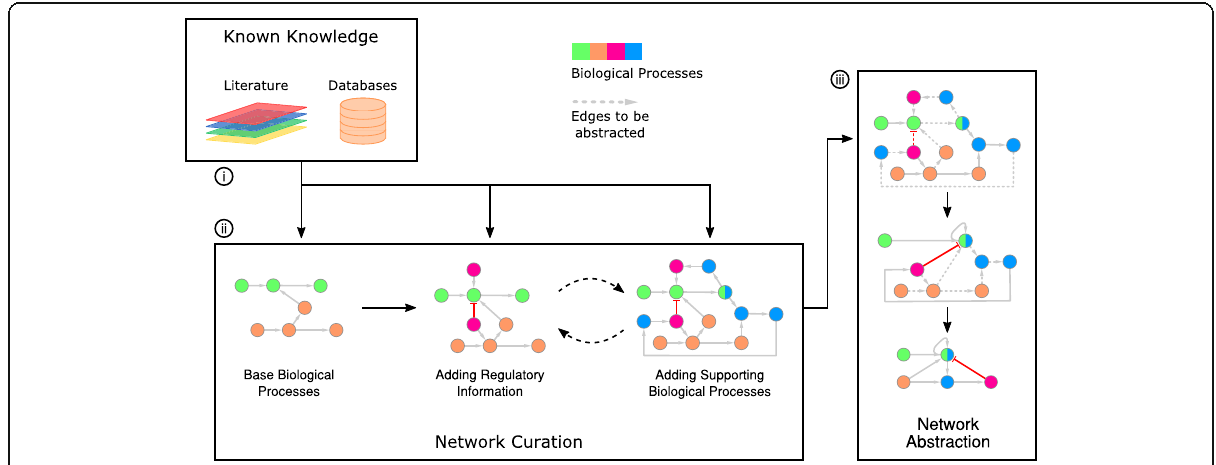
Fig. 1 Methodology overview showing the workflow to construct the abstracted network. (i) Known knowledge in the form of published literature and databases is queried regarding cellular metabolism. (ii) Base biological processes are isolated and then expanded by adding regulators and other related processes as long as they are related to cellular metabolism. (iii) The expanded network is then abstracted by merging edges such that only major components and rate-limiting steps